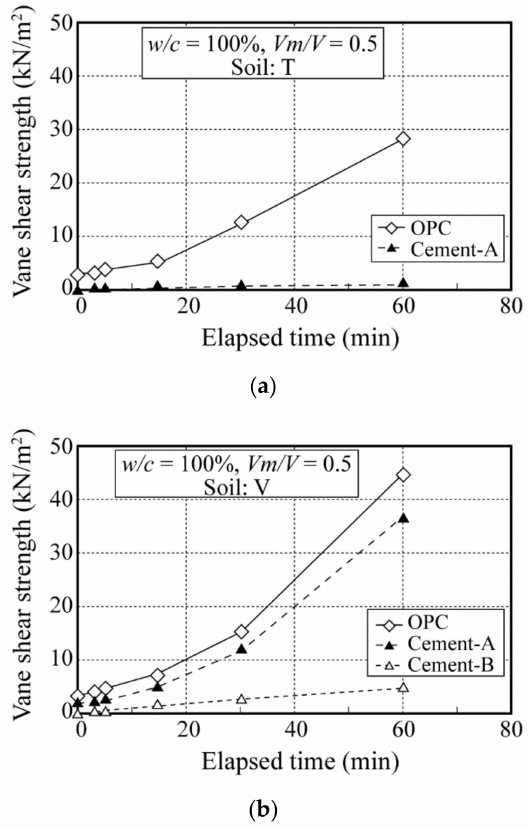
Figure 8. Increase in strength of the soil and cement mixture [12]. ( a ) Fresh stabilized soil, T; ( b ) fresh stabilized soil,